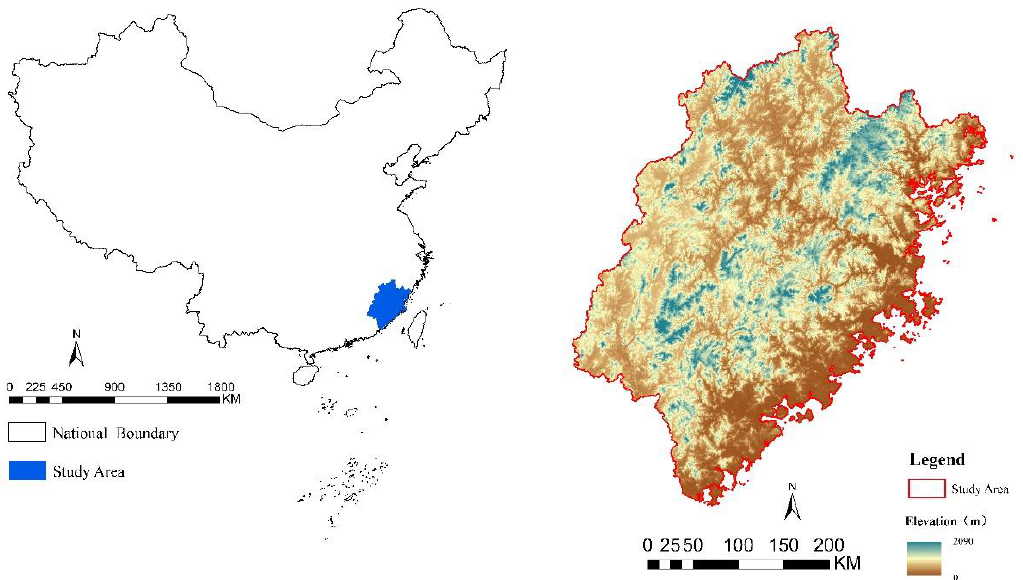
Figure 1. Geographical location of the study area.